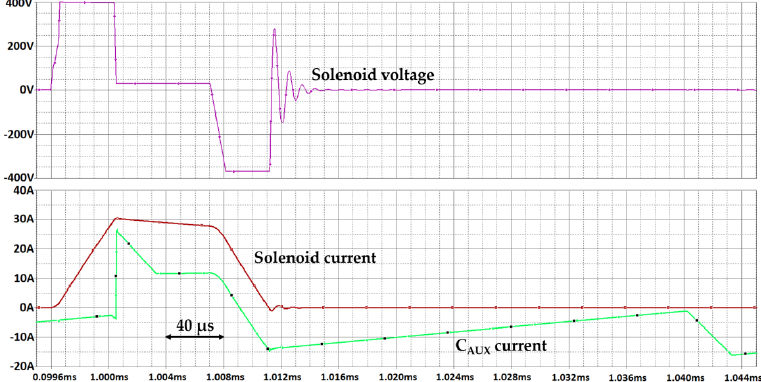
Figure 12. Simulated waveforms for the FB+buckpower supply.